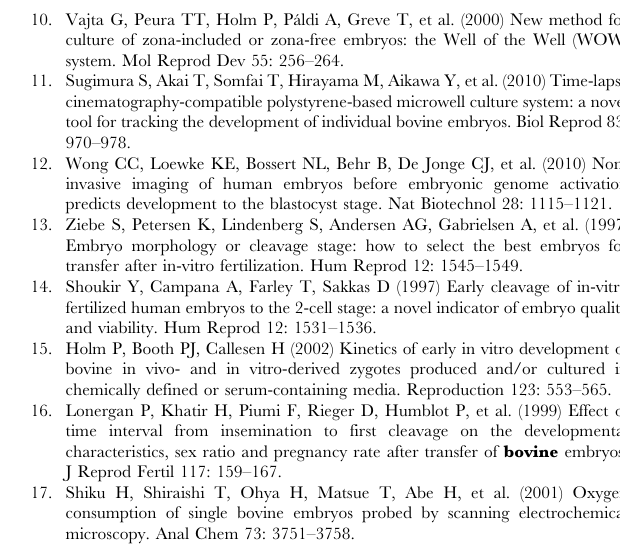
Table S1 Sequences of primers used for real-time RT- PCR. Table S2 The list of variables examined in current study. Table S3 Identified variables reflecting blastocysts qualities and conventional variables according to Inter- national Embryo Transfer Society manual.